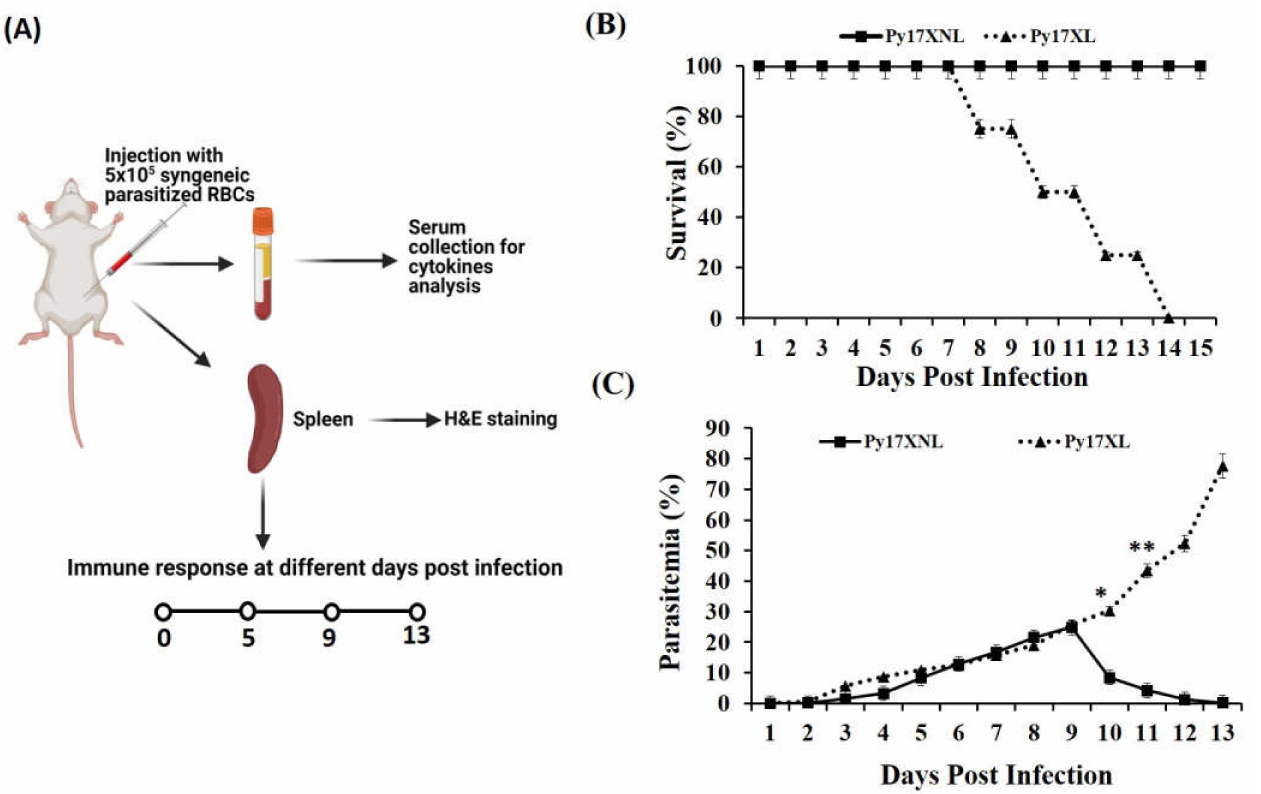
Figure 1. Parasitaemia and survival during lethal and non-lethal Plasmodium yoelii infection: ( A ) Balb/c mice were infected with 5 × 10 5 Plasmodium yoelii 17XL and Plasmodium yoelii 17XNL parasitized RBCs via intra- peritoneal (i.p) injection. Malaria parasites infected mice were monitored for immune response, survival and parasitemia. ( B ) The survival rate of mice infected with Py 17XL (triangle, n = 12) and Py 17XNL (square, n = 12). Data is shown as mean ± SD from 12 mice pooled from three independent experiments. ( C ) Thin blood smears were prepared from the tail vein at various time points as indicated in the figure and stained with Giemsa stains. Parasitemia was determined by counting the percentage of infected cells per 5000 RBCs per slide. Parasitemia of lethal Py 17XL (triangle, n = 12) and non-lethal Py 17XNL (square, n = 12) at different time points. The unpaired student’s t -test was used to determine the statistical significance (** p < 0.001, * p <